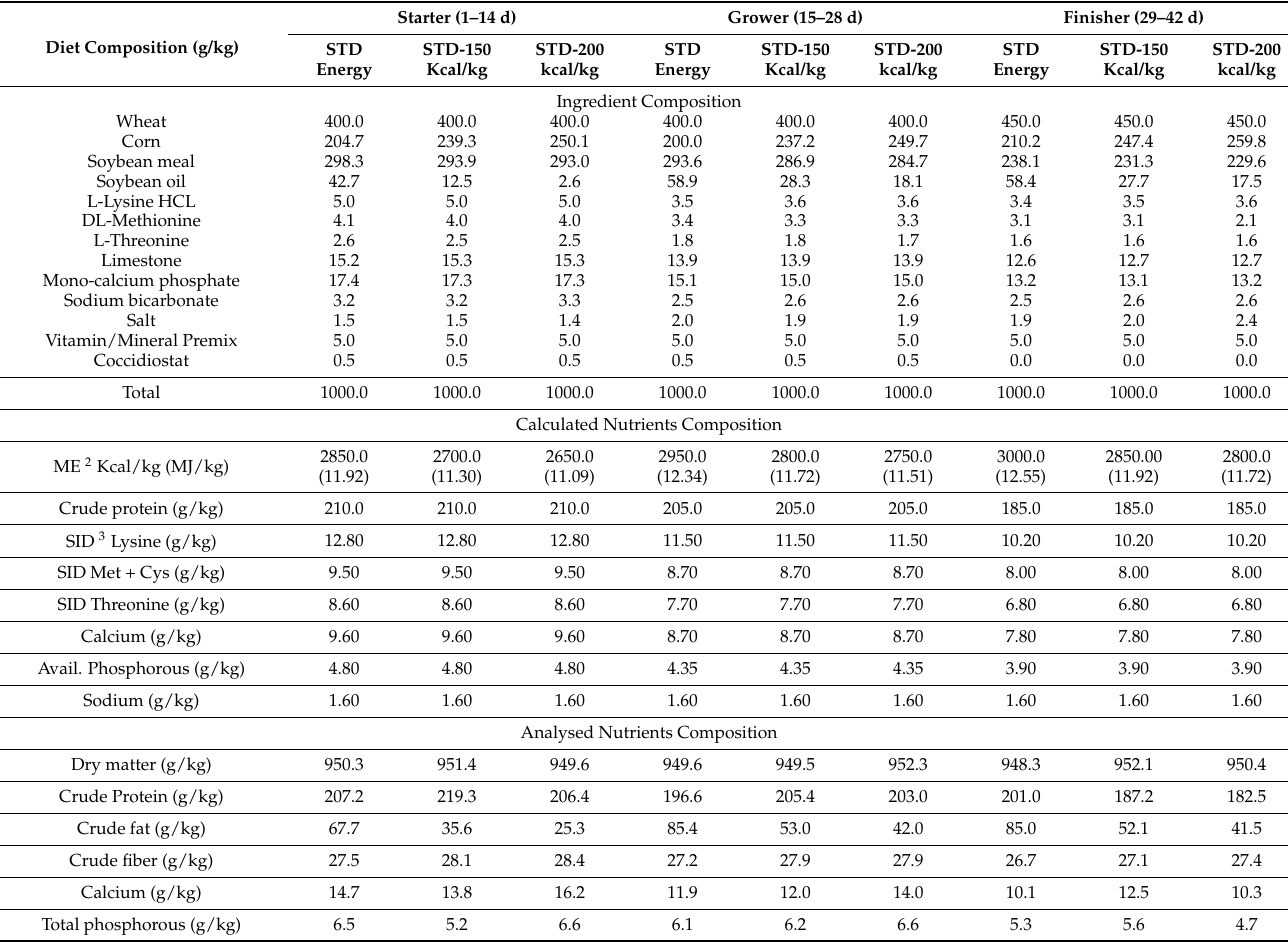
Table 1. Ingredient composition as well as the calculated and analysed nutrient composition of the experimental diets 1 .